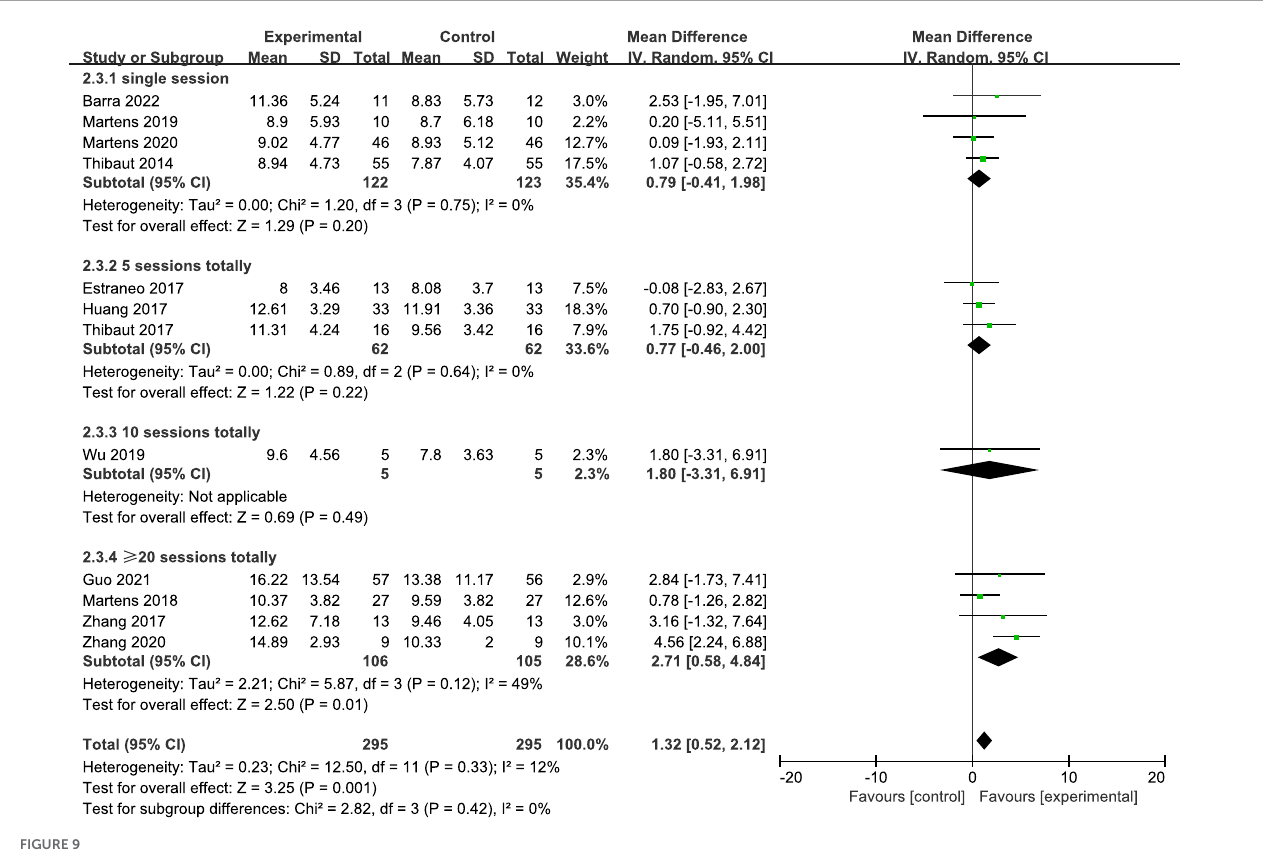
FIGURE9 Subgroup analysis of stimulation doses on CRS-R scores in patients with